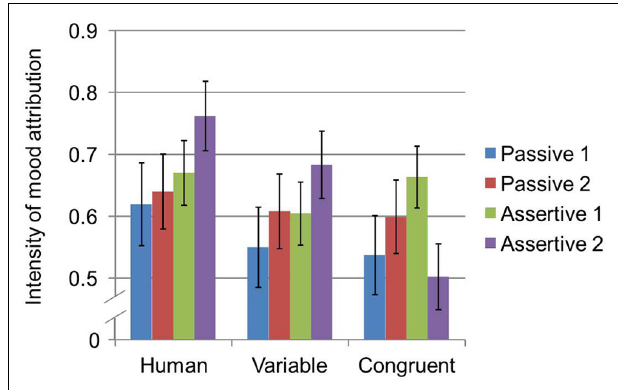
FIGURE 7 |Three-way interaction between proxemic behavior, measurement time, and gaze on intensity of emotional attributions measured by the